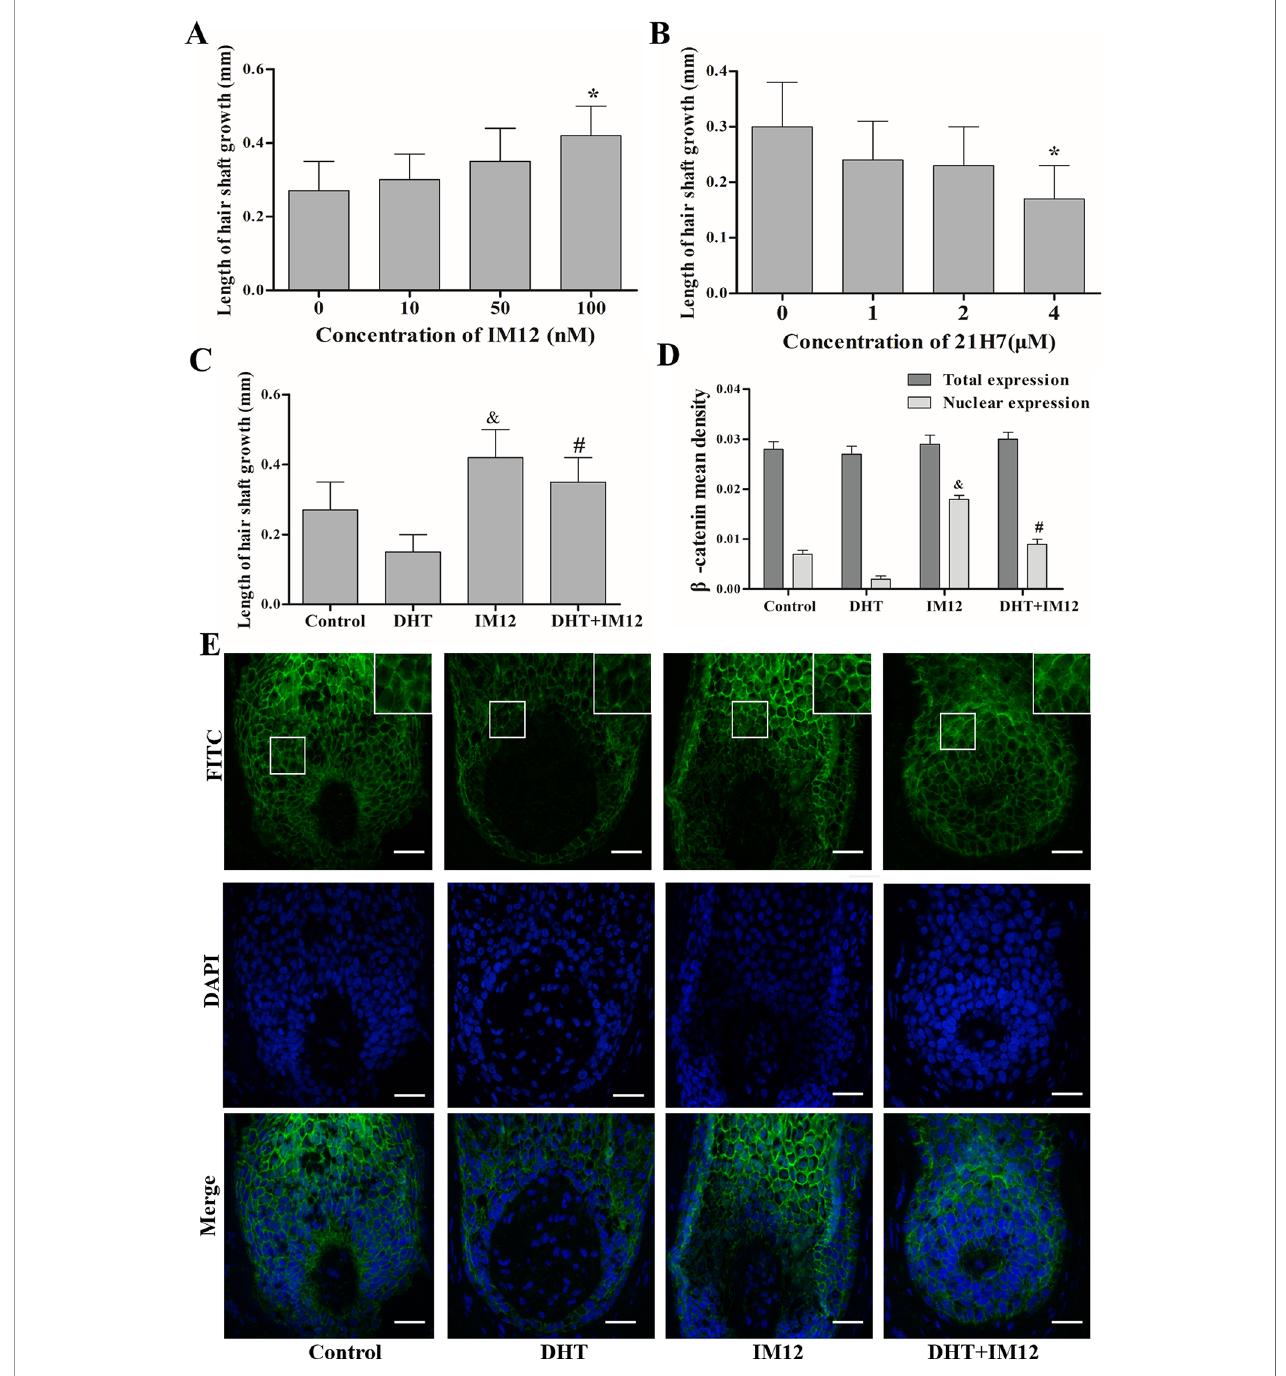
FIGURE 6 | Dihydrotestosterone (DHT) regulates human hair follicles (HFs) growth through the Wnt/ b -catenin pathway. HFs were cultured with IM12 (50, 100, or 500 nM), 21H7 (1, 2, or 4 µM), DHT (10 -6 mol/L), IM12 (500 nM), or 10 -6 mol/L DHT and 500 nM IM12. (A , B) Mean growth rates of hair shafts treated with IM12 and 21H7 (n = 10). (C) Mean growth rates of hair shafts treated with DHT and IM12 (n = 10). (D , E) Immuno fl uorescence staining and mean fl uorescence intensity of b -catenin in HFs cultured with DHT and IM12 (n = 6). Magni fi cation: 200× and 400×. The data are presented as the mean ± SD. Each bar represents the mean of three independent experiments performed in triplicate. Compared with the control ( 0 ) group, * P < 0.05 , & P < 0.05 and # P < 0.05. Scale bar 50 m m